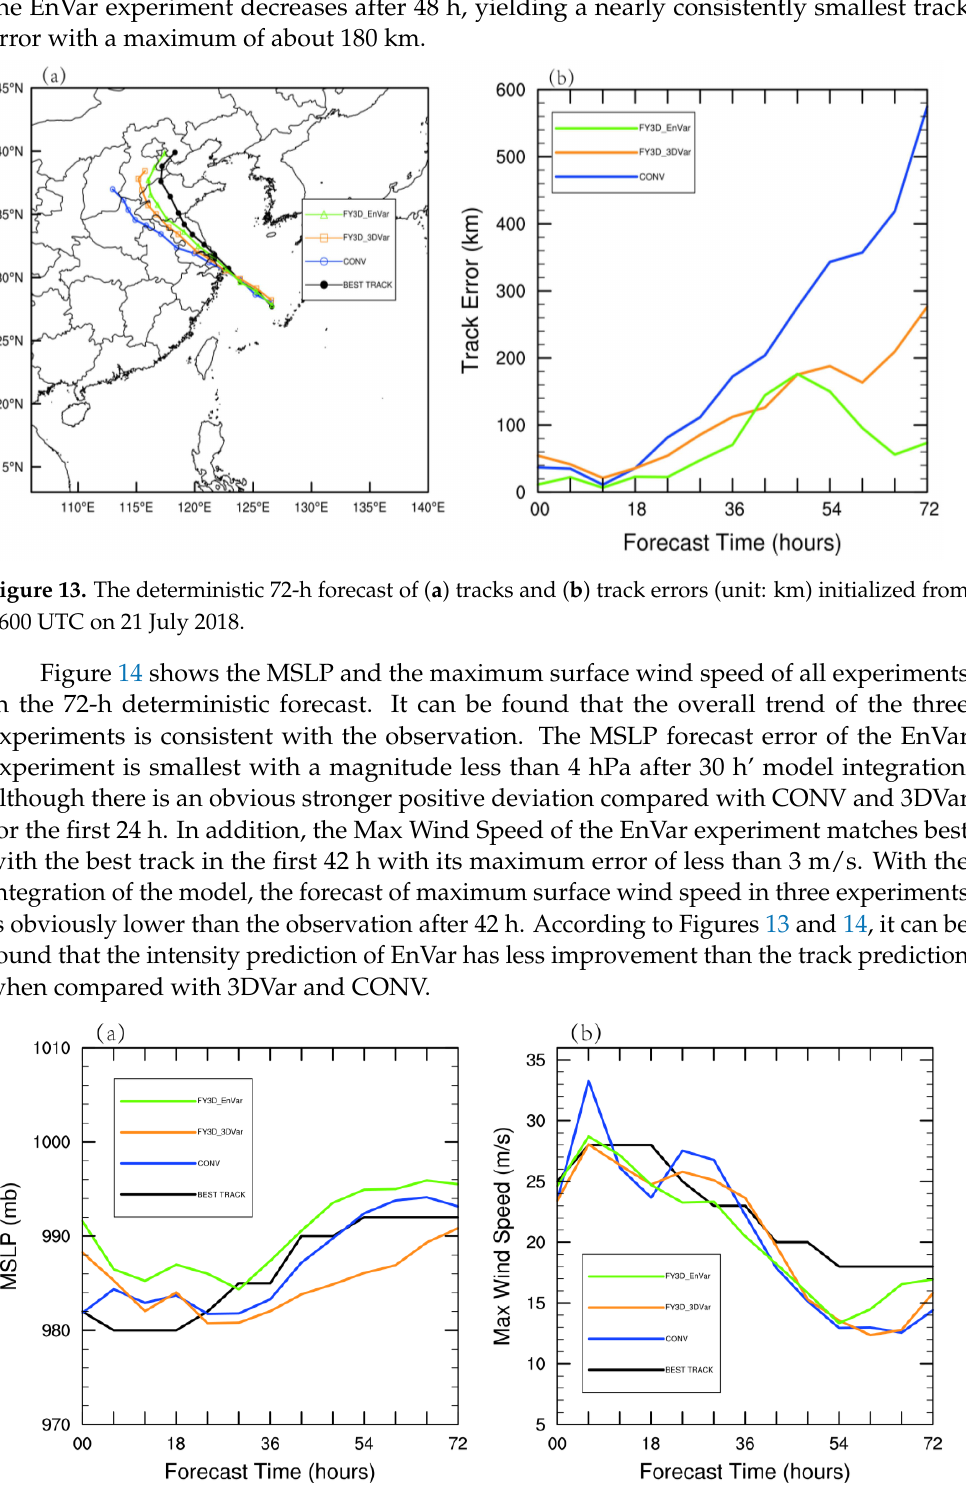
Figure 14. The deterministic 72-h forecast of ( a ) MSLP (unit: hPa) and ( b ) maximum surface wind speed (unit: m/s) initialized from 0600 UTC on 21 July 2018.